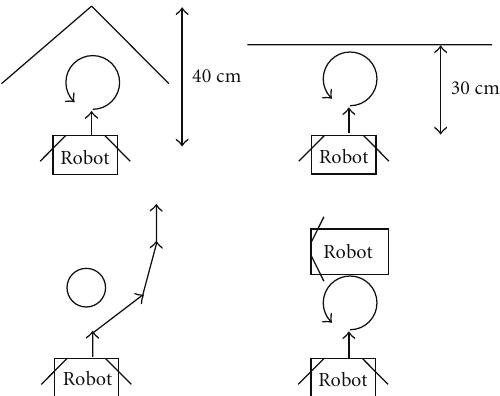
Figure 17: Trajectories followed by the two robots during the collaborative task.